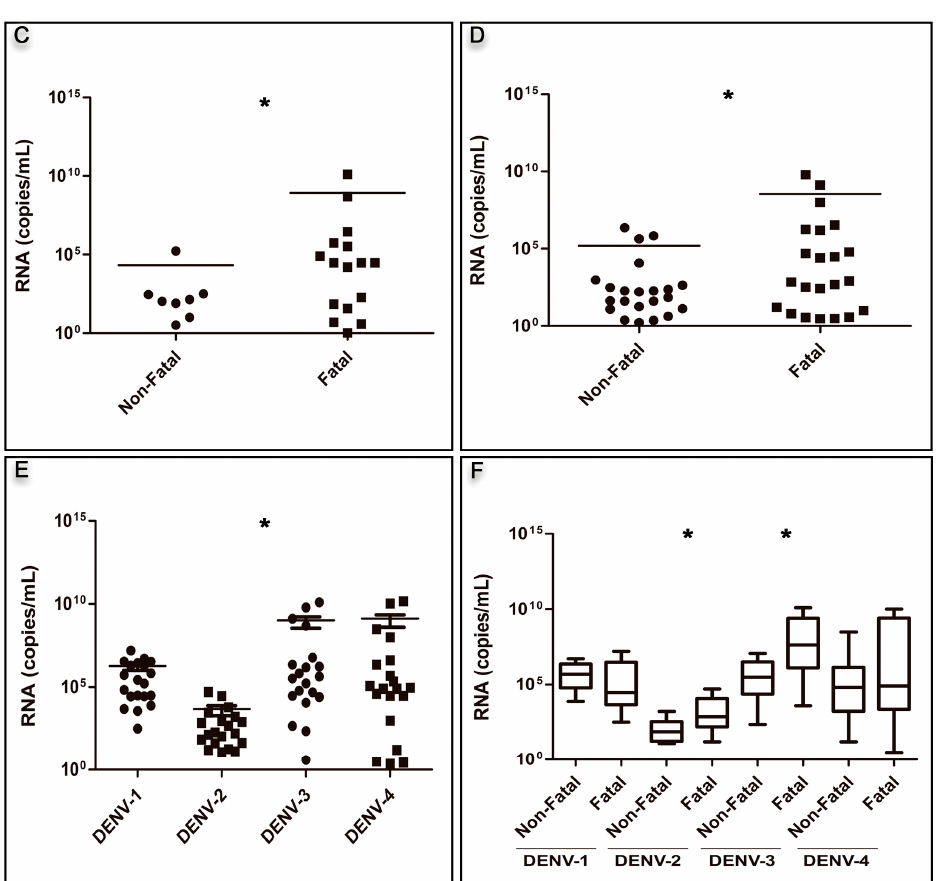
Figure 2. RNA viral load quantification by qRT-PCR ( A ) according to the disease outcome (non-fatal: n = 40; fatal: n = 40) p = 0.06 by using t test; ( B ) by type of infection (primary: n = 24 versus secondary: n = 45) using t test; ( C ) in primary non-fatal ( n = 8) versus fatal ( n = 16) cases, * p < 0.01 using t test; ( D ) in secondary non-fatal ( n = 23) versus fatal ( n = 22) cases, * p < 0.01 using t test; ( E ) in the analysis of DENV serotype regardless of the disease outcome ( n = 80), * p < 0.01 by ANOVA test; ( F ) in the analysis of the distinct DENV serotypes according to the disease outcome (fatal: n = 10 and non-fatal/serotype) using t test. For DENV-2 fatal versus non-fatal cases, * p < 0.01, and for DENV-3 fatal versus non-fatal cases, * p < 0.01.